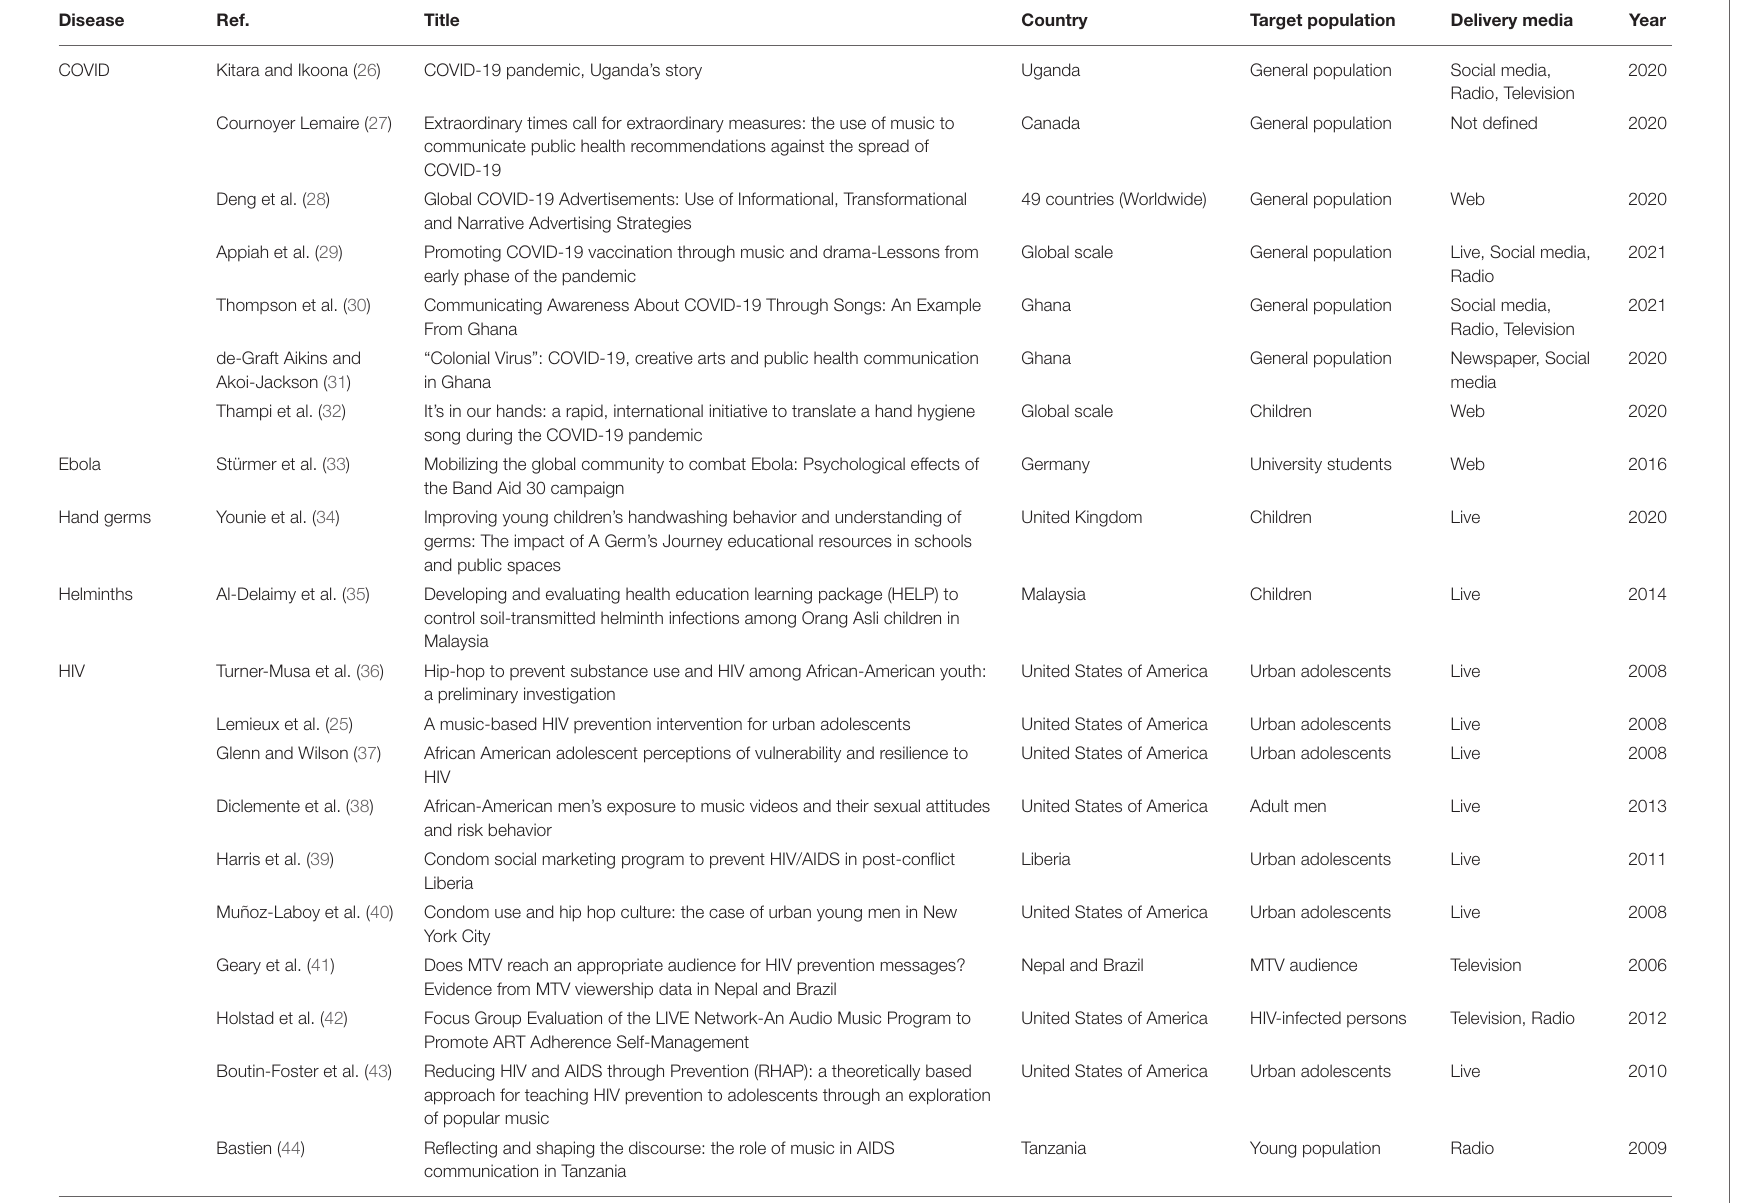
TABLE 1 | Examples of music interventions to prevent and control endemic and emerging infectious diseases retrieved from PubMed published between 2006 and 2021. Disease